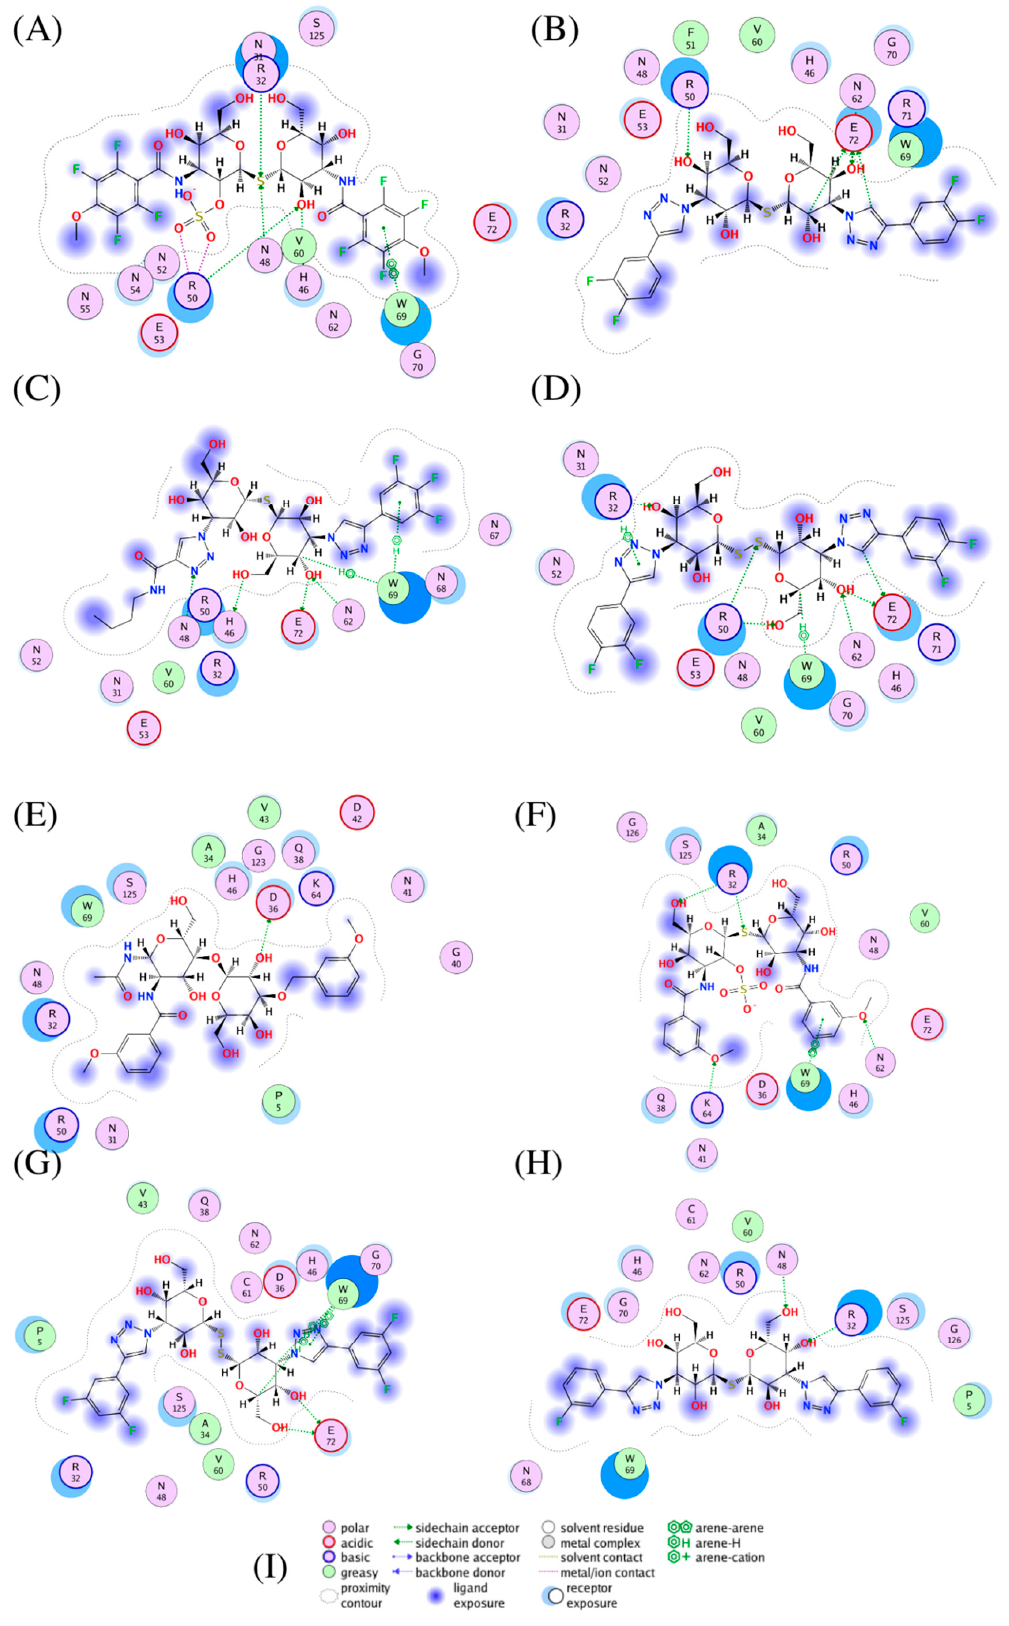
Figure 7. Ligand interaction plots of compounds selected for Gal-3 inhibition. ( A ) A6J ( B ) NEW1, ( C ) NEW4, ( D ) NEW6 ( E ) 8VT ( F ) GMK ( G ) NEW8 and ( H ) TD2. A graphical key ( I ) is included to help interpret the 2-D part of the ligand interactions